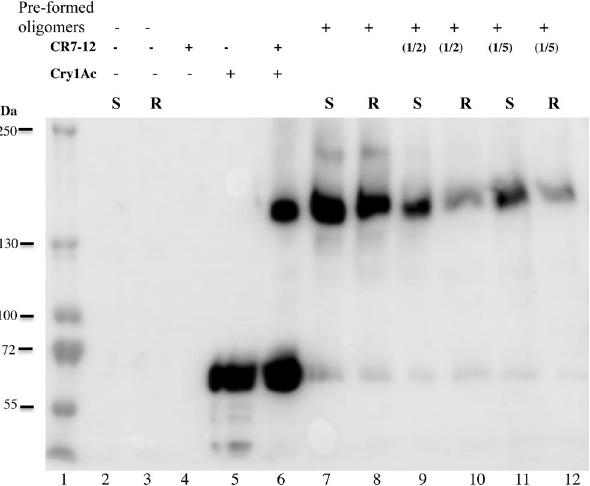
Figure 4. Association of preformed Cry1Ac oligomer with BBMV from susceptible and resistant populations of P. xylostella . One μ g of Cry1Ac toxin was incubated with M. sexta cadherin fragment CR7-CR12 (1:4) for two h and Cry1Ac oligomers were revealed by western blot as described in experimental procedures. BBMV (20 μ g) were incubated 1 h with pre-formed oligomers and BBMV were recovered by centrifugation and revealed by western blot. Lane 1, molecular weight markers; lane 2, BBMV from Geneva 88; lane 3, BBMV from NO-QAGE; lane 4, CR7-CR12 protein fragment; lane 5, Cry1Ac activated toxin; lane 6, CR7-CR12 fragment with Cry1Ac toxin; lane 7, BBMV from Geneva 88 incubated with preformed Cry1Ac oligomer; lane 8, BBMV from NO- QAGE incubated with preformed Cry1Ac oligomer; lane 9, BBMV from Geneva 88 incubated with preformed Cry1Ac oligomer diluted two-fold; lane 10, BBMV form NO-QAGE incubated with preformed Cry1Ac oligomer diluted two-fold; lane 11, BBMV from Geneva 88 incubated with preformed Cry1Ac oligomer diluted five-fold; lane 12, BBMV from NO-QAGE incubated with preformed Cry1Ac oligomer diluted